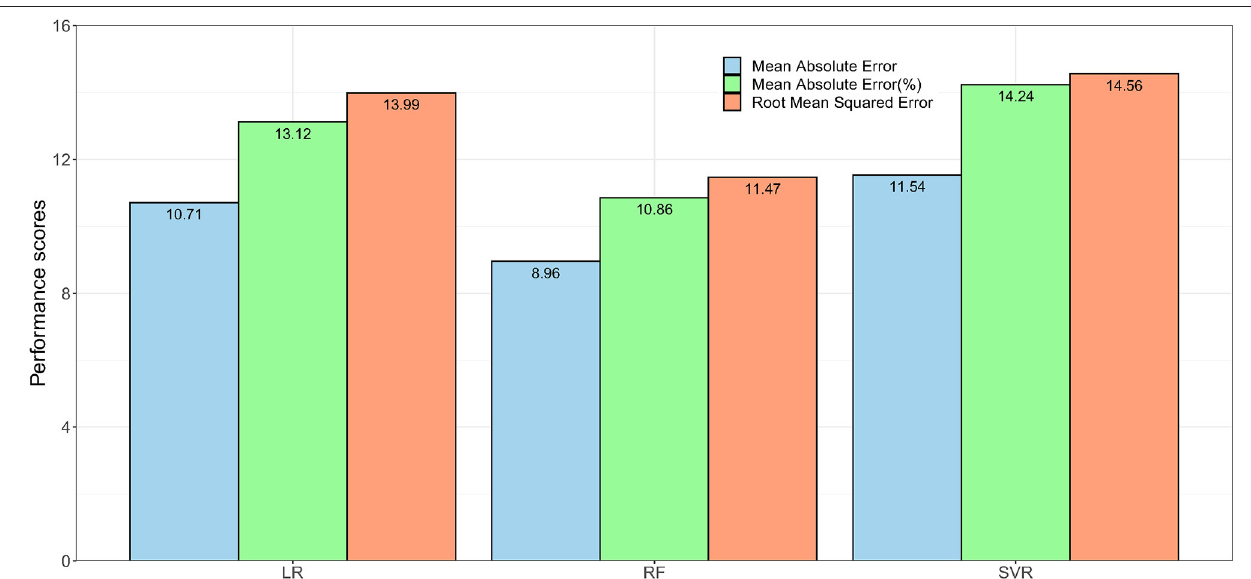
FIGURE 2 | The performance of the regression models. Model 1P used extracted features from speech and breath parts with sex, height and weight to predict lung function in terms of FEV 1 %. Here, LR = Linear Regression, RF = Random Forest, and SVR = Support Vector Regression.